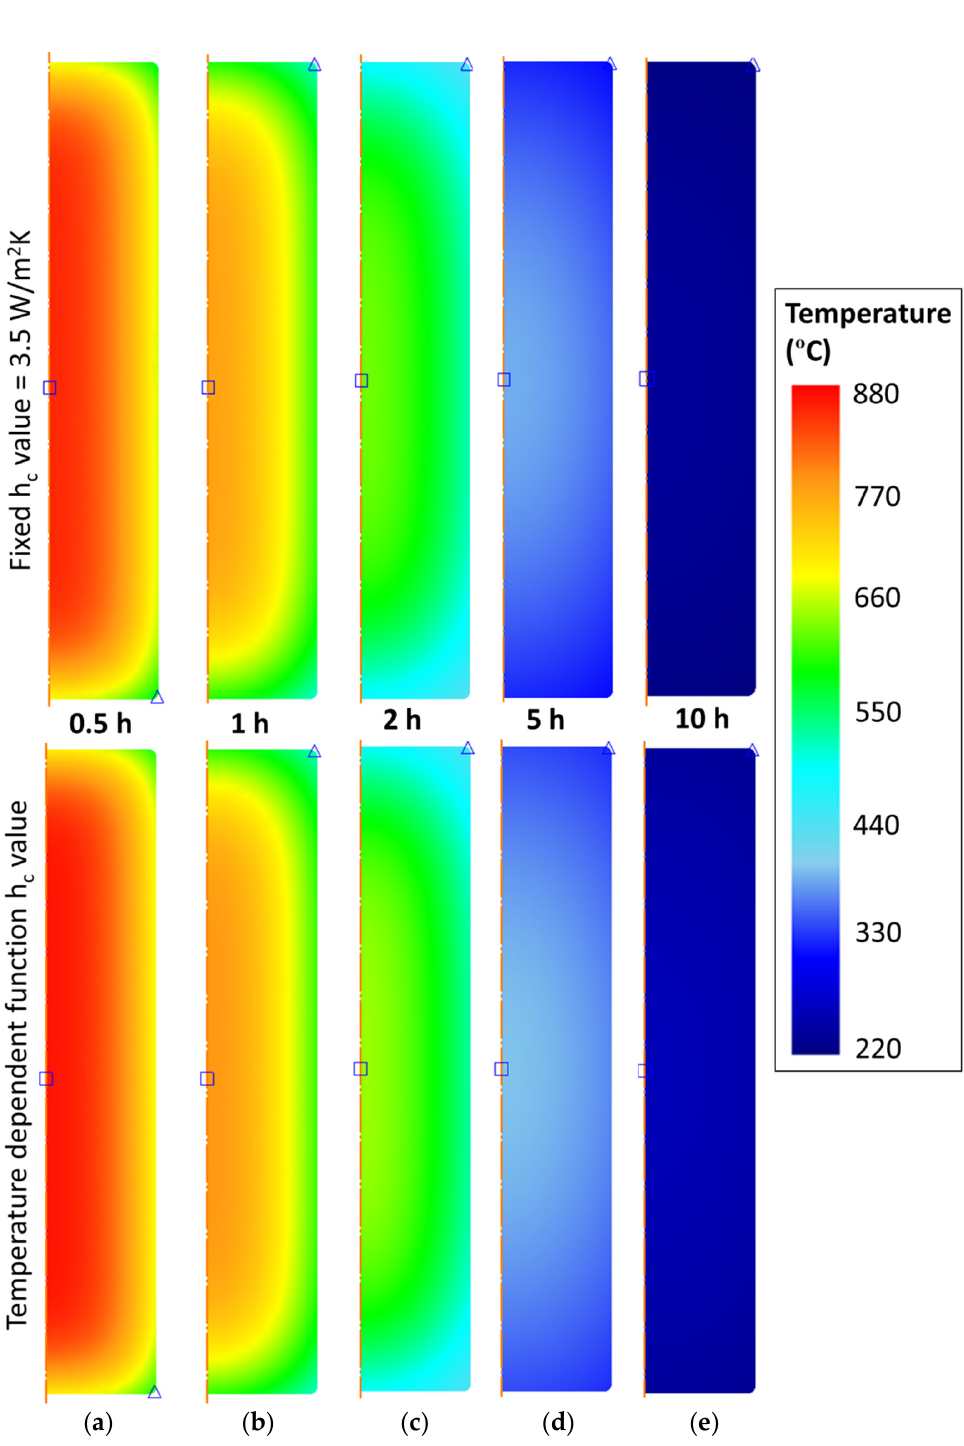
Figure 4. FE predictions of billet natural cooling after ( a ) ½ h, ( b ) 1 h, ( c ) 2 h, ( d ) 5 h, and ( e ) 10 h for ( top ) constant convection coefficient and ( bottom ) temperature-dependent convective term.